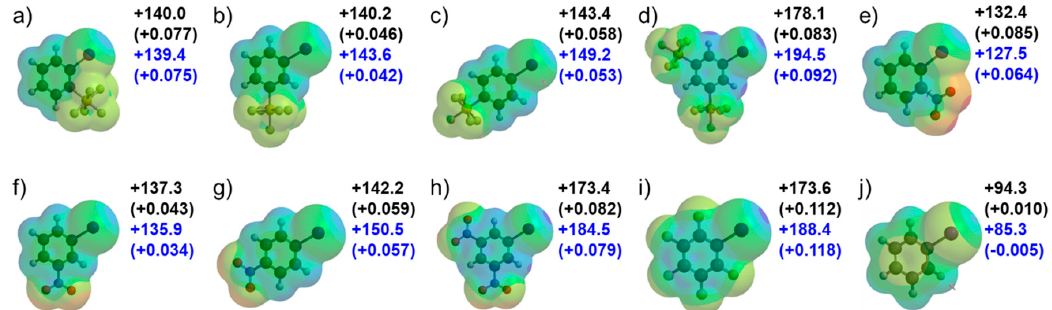
Figure 2. The electrostatic potential surface of molecules with maximum values at iodine atoms in a vacuum (black) and in water (blue). The numbers indicated interaction energy (in kJ/mol) and Mulliken charge in parenthesis; ( a ) o -SF 5 -iodobenzene ( 1a ), ( b ) m -SF 5 -iodobenzene ( 1b ), ( c ) p -SF 5 -iodobenzene ( 1c ), ( d ) 3,5-bis-SF 5 -iodobenzene ( 1d ), ( e ) o -NO 2 -iodobenzene, ( f ) m -NO 2 -iodobenzene,